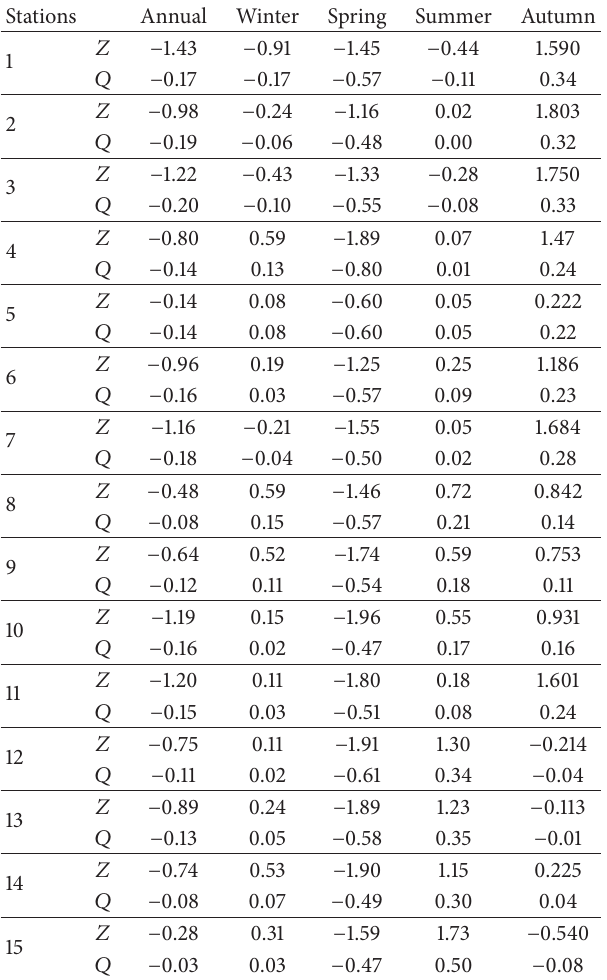
Table 4: Mann Kendall and TSA results of precipitation during the period of